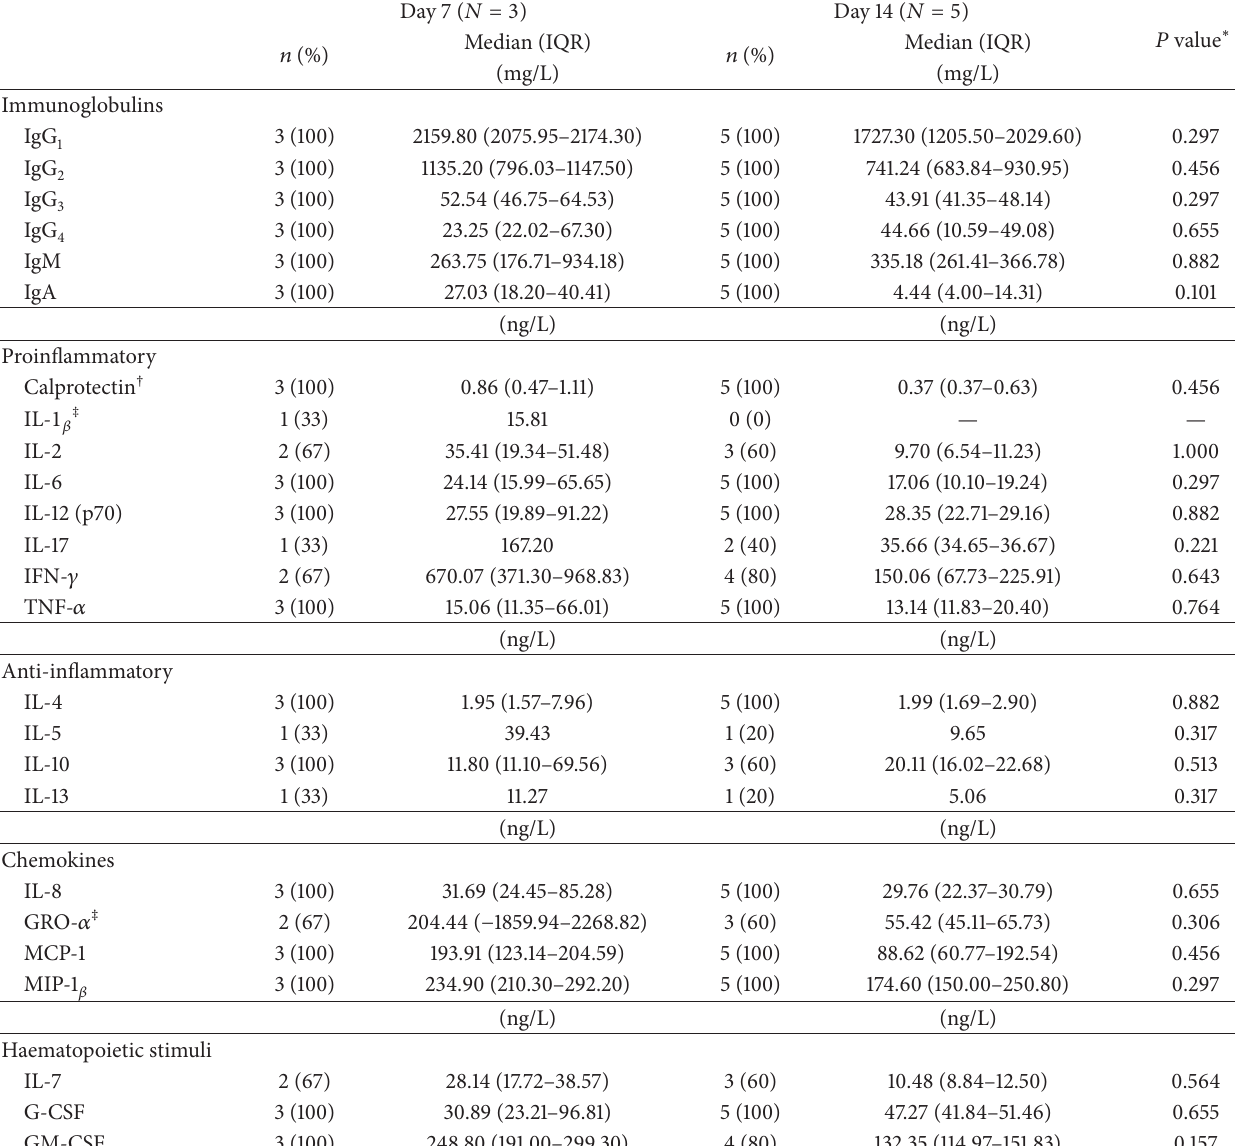
Table 3: Frequency and concentration of immune compounds in plasma samples ( 𝑁 = 8) along